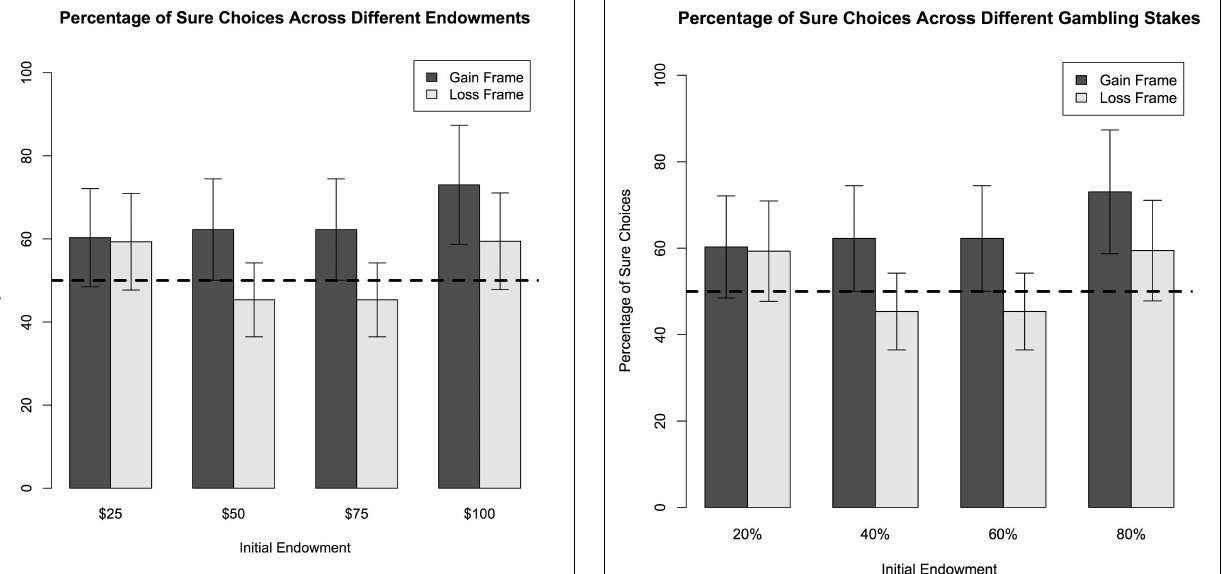
In measures of cognition, strategic control [ t (1,193) = −